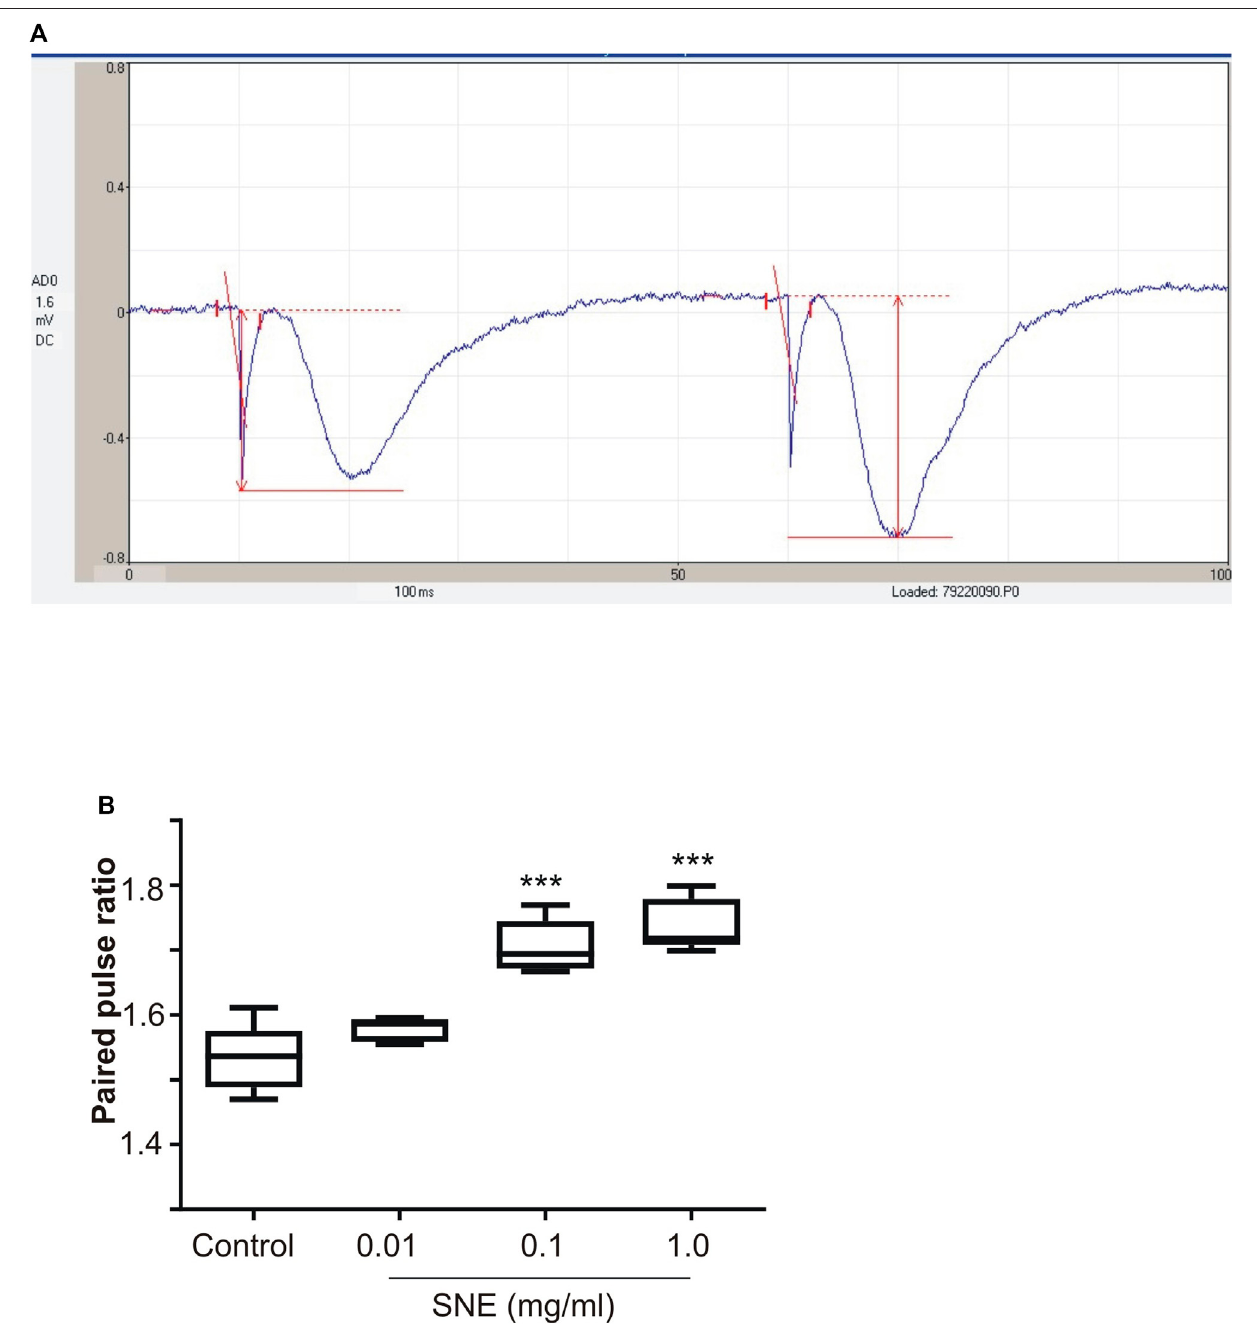
FIGURE 3 | (A) A typical recording of paired fEPSP showing pair-pulse facilitation (B) Effect of SNE (0.01, 0.1, and 1.0 mg/ml) on paired pulse ratio in rat hippocampal slicesafter astablebaselineperfusedwithnormal aCSF.Dataismean ± SEM(n (cid:2) 5). *** p < 0.001compared withbaseline,one-wayANOVA followed bya Dunnett ’ s multiple comparison